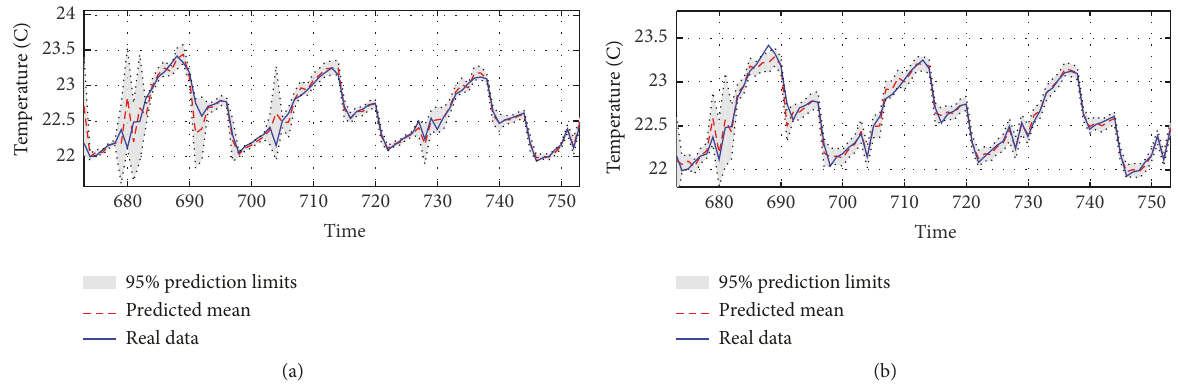
Figure 8: The predicted temperature of the west zone using (a) the proposed SHS model and (b) the full GP model.